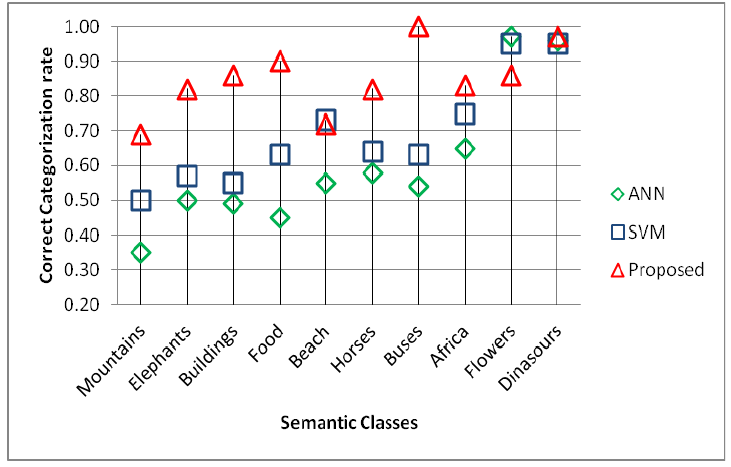
Figure 7. Image retrieval comparison against artificial neural networks (ANN) and support vector machines (SVM) classifiers in terms of precision.